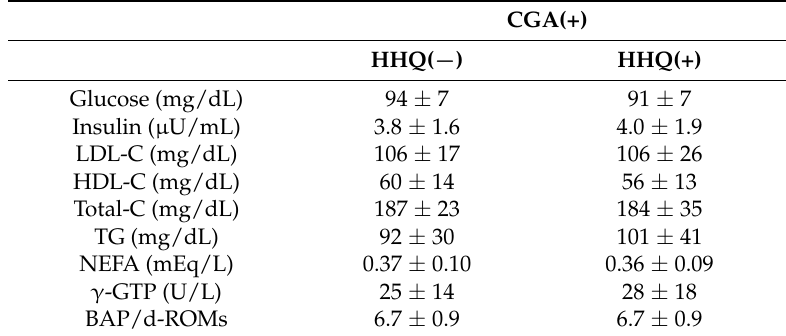
Table 6. Blood parameters under fasting conditions after four-week